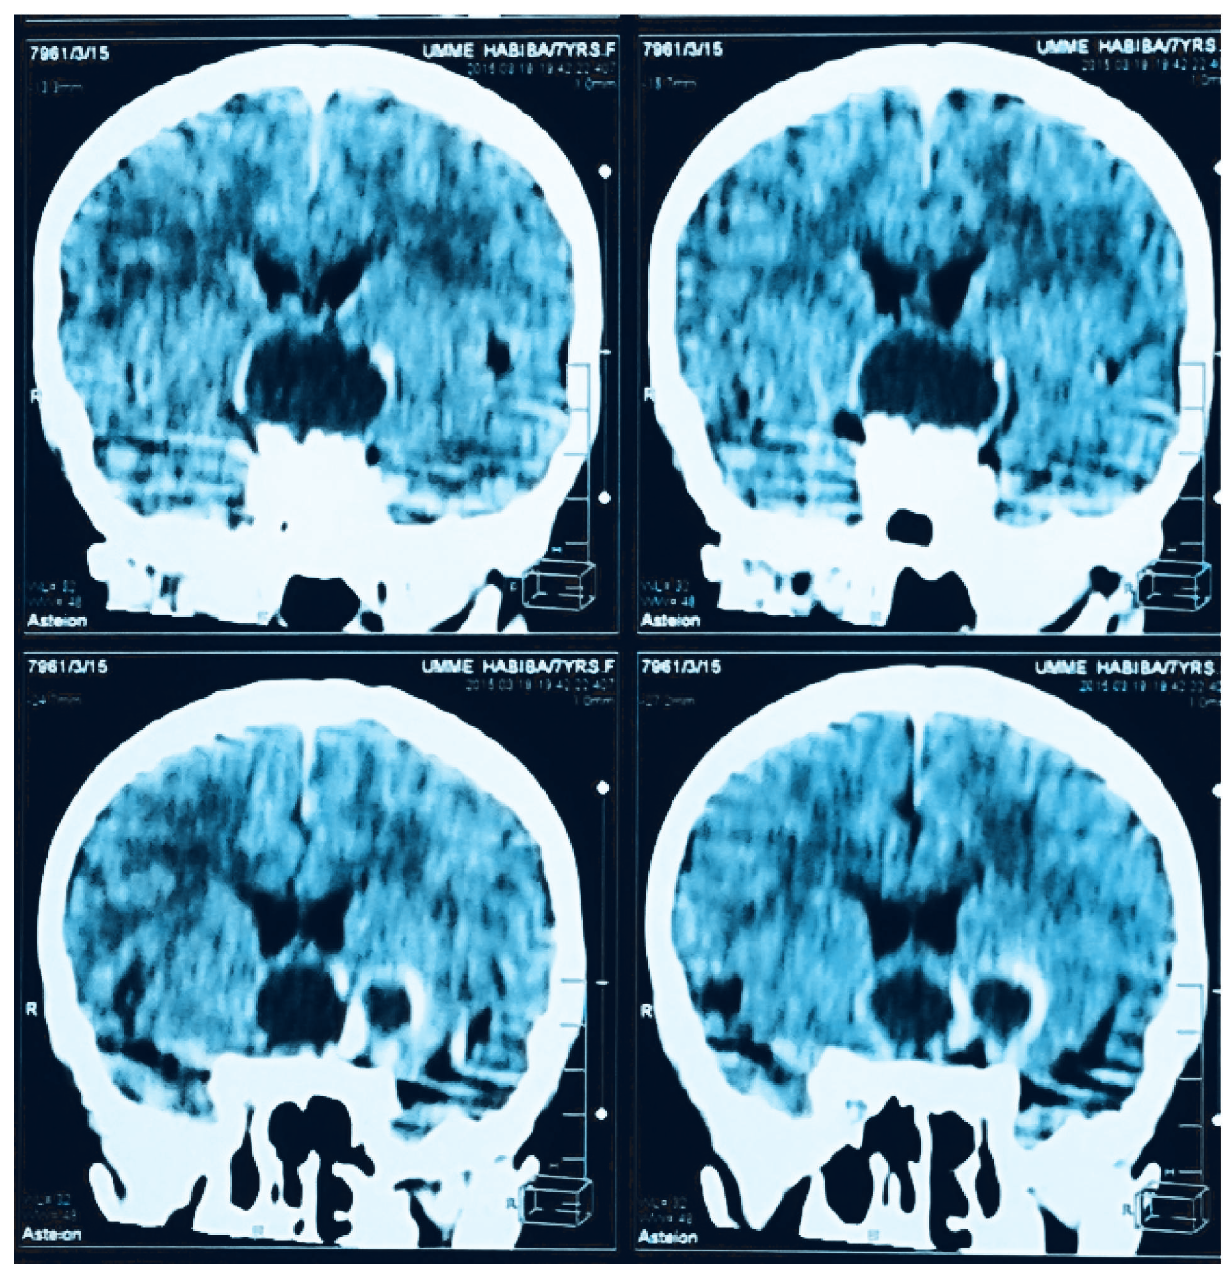
Fig 1. A loculated multicystic mass in the midline suprasellar region with heterogenous soft tissue nodules (coronal section)